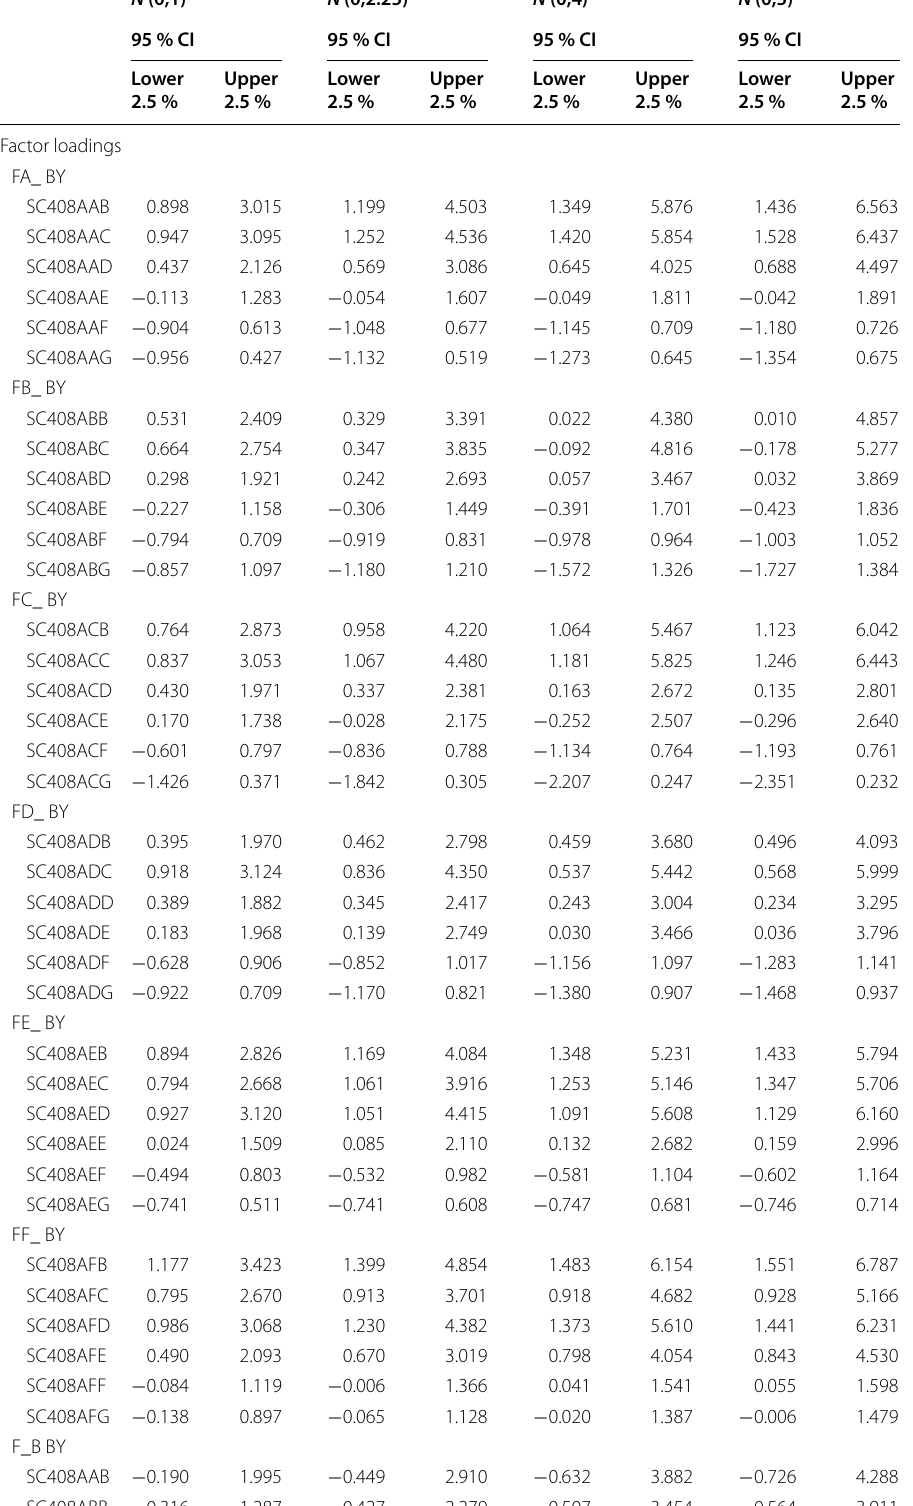
Table 4 Credible intervals of each